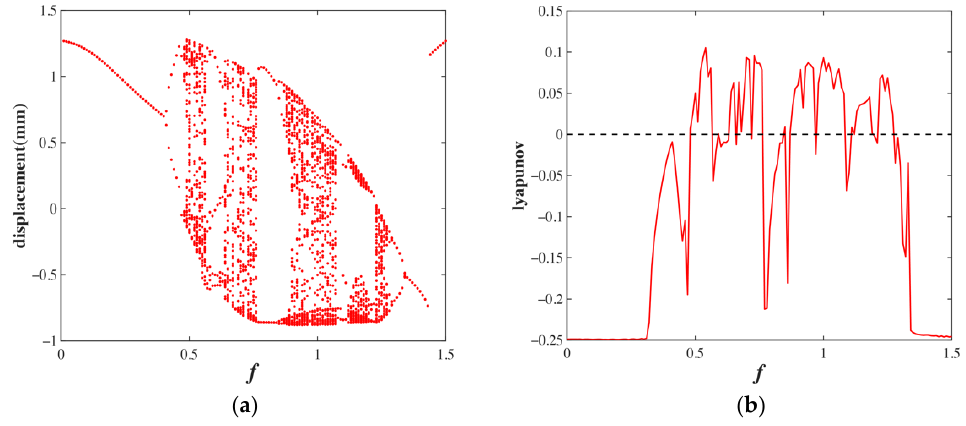
Figure 19. Bifurcation diagram and Lyapunov exponent diagram of the system with f at α = 1: ( a ) Bifurcation diagram; ( b ) Lyapunov exponent diagram.